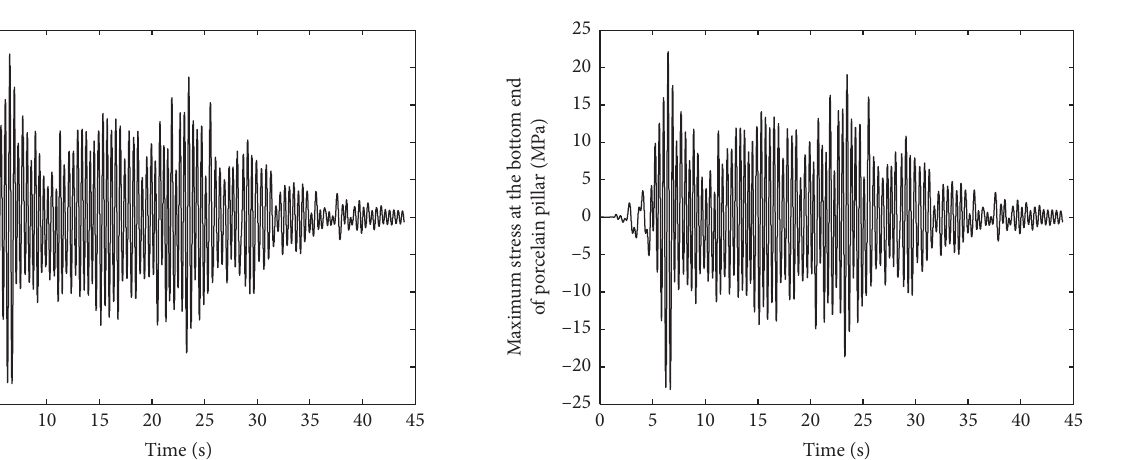
Figure 17: Maximum stress at the bottom of porcelain pillar ( a � 0.3 g, η � 0).